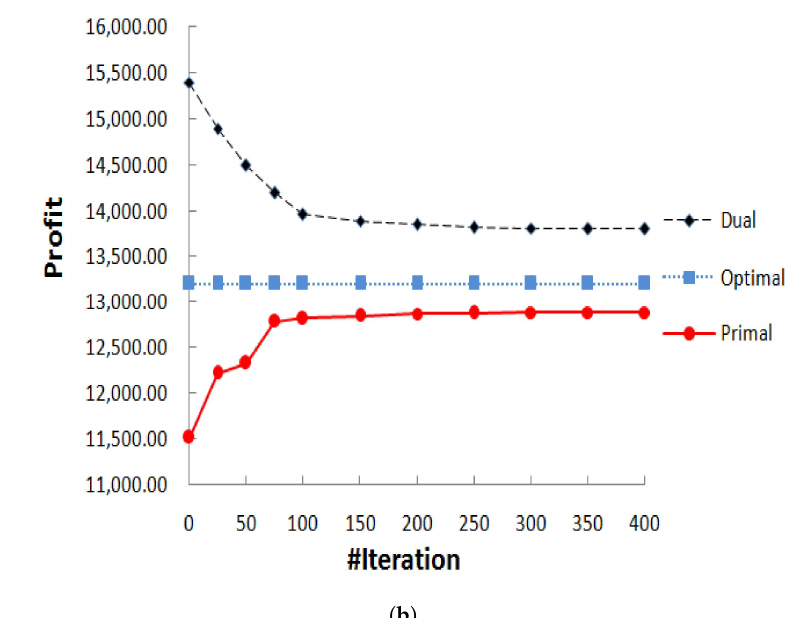
Figure 2. ( a ) Runtime comparison between the global MILP and LDD, ( b ) Duality gap in the synthetic data set with 30